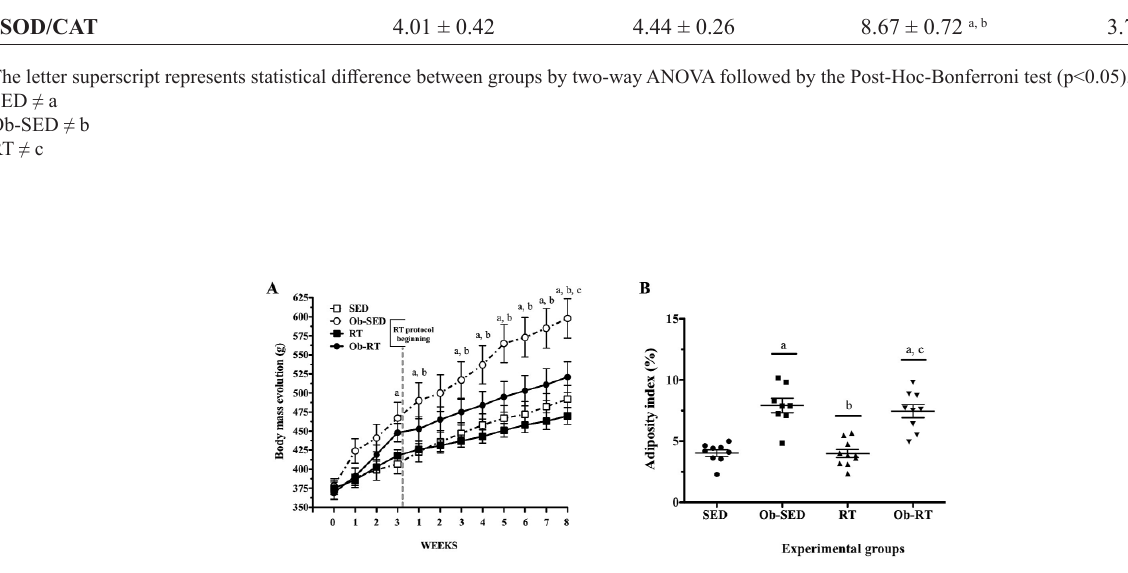
Figure 2 - Effect of high-fat diet and RT on A) body mass evolution (g); and B) Adiposity index (%).